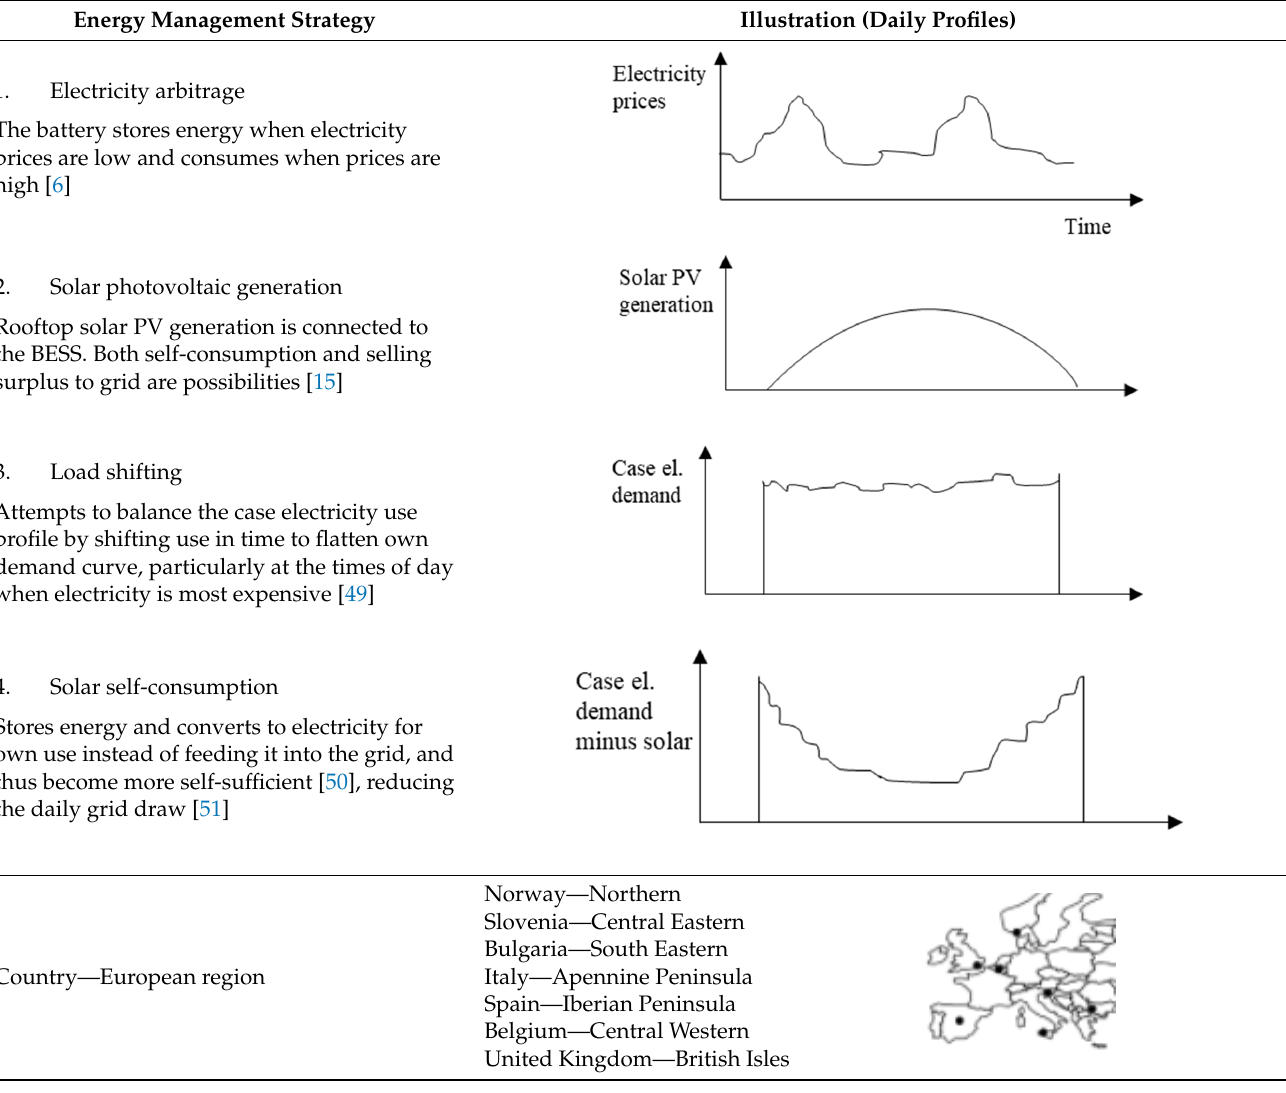
Table 1. The four energy management strategies and the European countries and regions covered in the multiple scenario analysis.